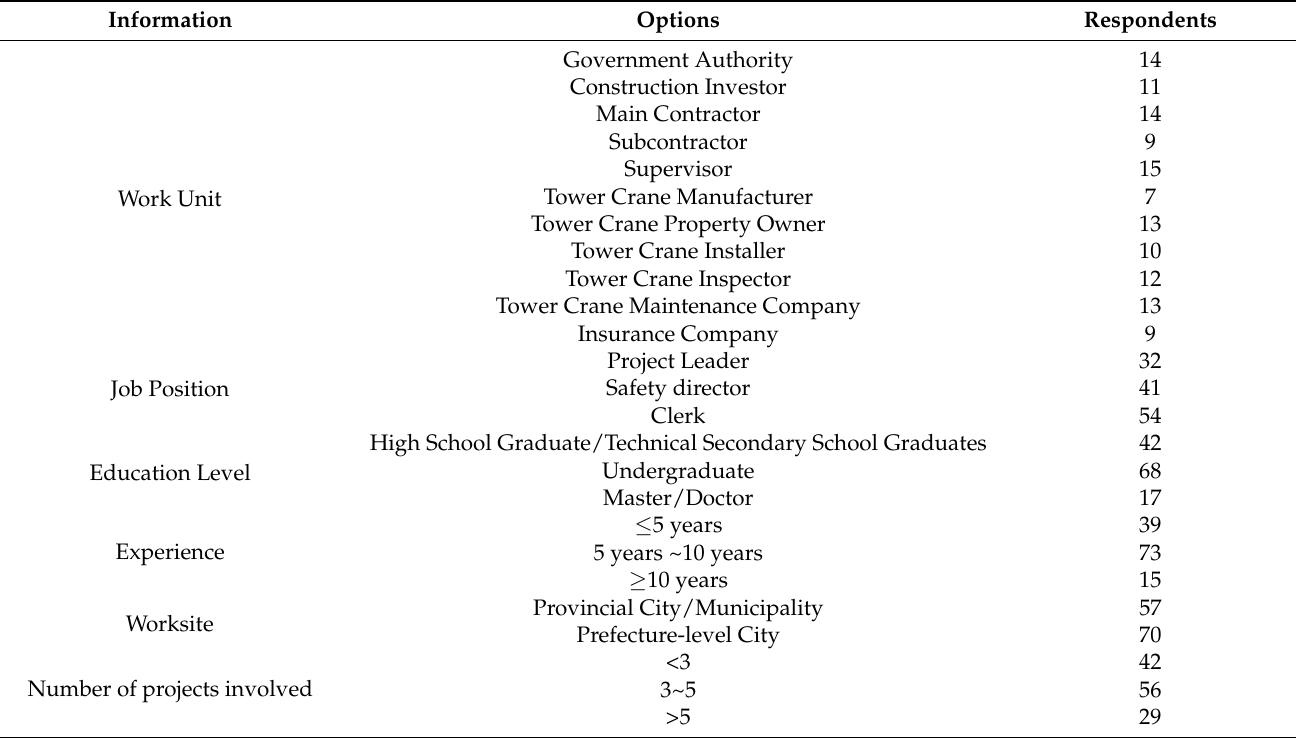
Table 4. Summary of respondents’